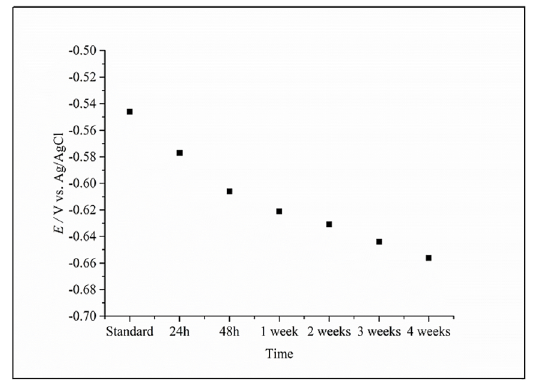
Figure 6. Punctual values of the open circuit potentials for ASTM A 131 grade A36 carbon steel immersed in diesel oil S10 over 30 days. variations in the impedance values, indicating that there was a change in the resistance value of the solution in function of the immersion time. This behavior confirmed that there is an influence on the composition of the fluids (oil/water) in contact with each other, thus altering the conductivity of the system.